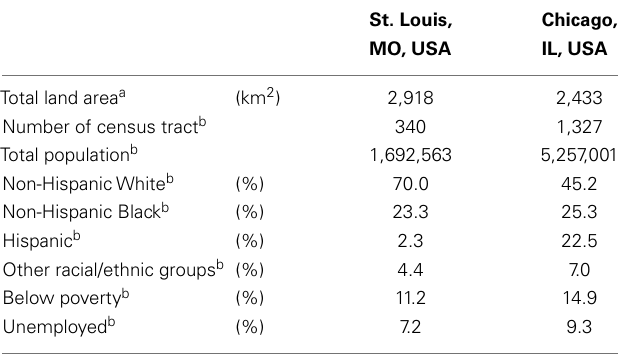
Table 1 | Description of the two Midwestern US cities